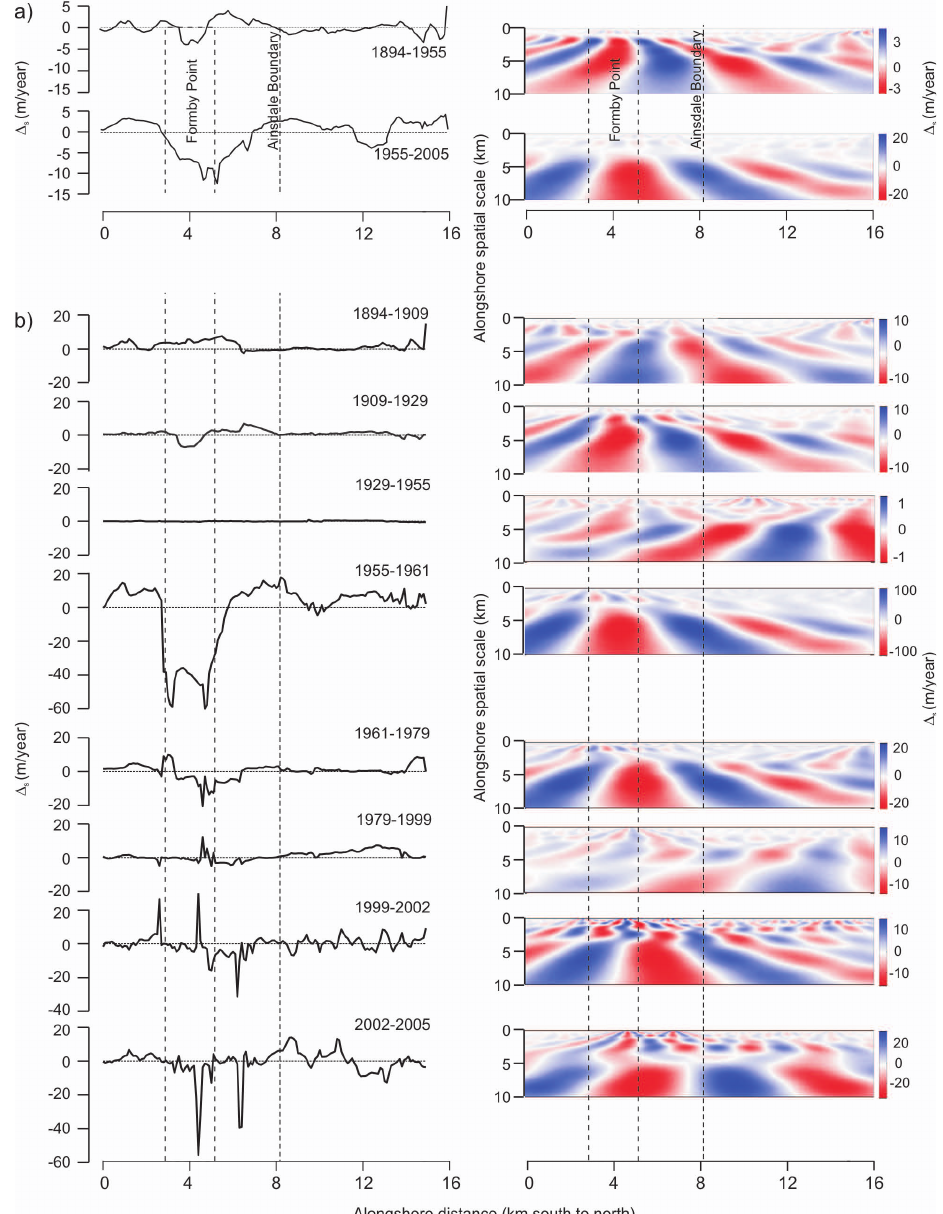
Fig. 4. Time-series (left panels) and wavelet transforms (right panels) showing rate of change in shoreline position ( 1 s): (a) for the two longer periods ( > 50yr) and (b) for the eight shorter periods (3 to 26yr). Dashed lines indicate the position of Formby Point and Ainsdale Boundary (Fig.